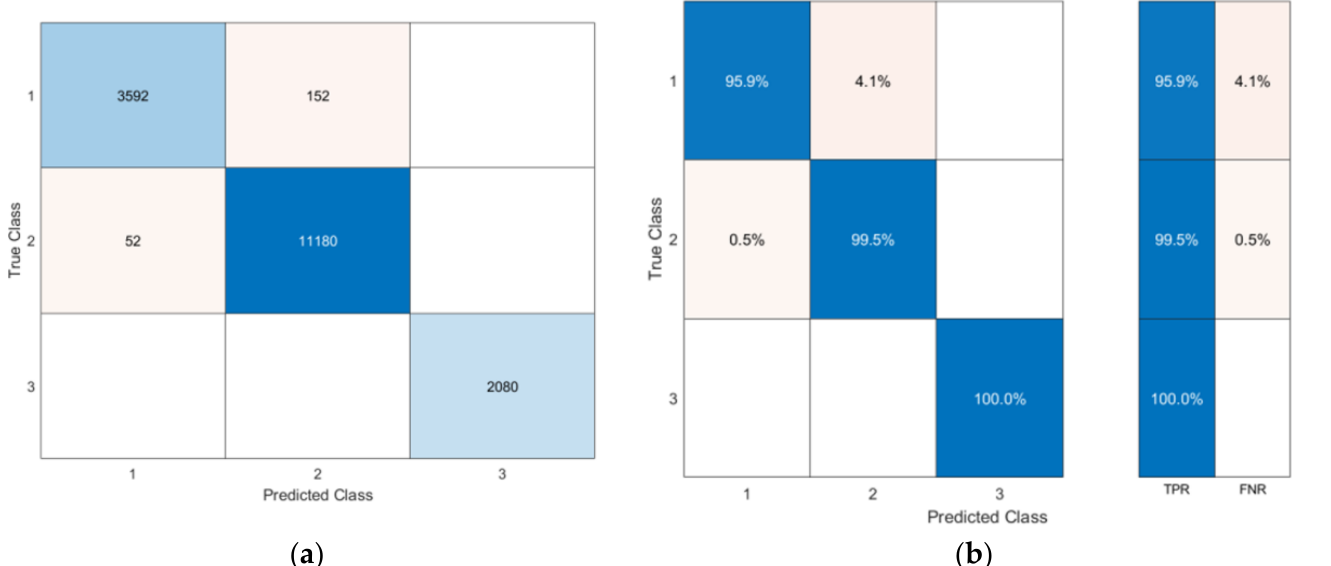
Figure 9. Confusion matrix corresponding to the highest accuracy shown in Table 9: ( a ) confusion matrix showing numerical values ( b ) TPR and FNR (in percentages).